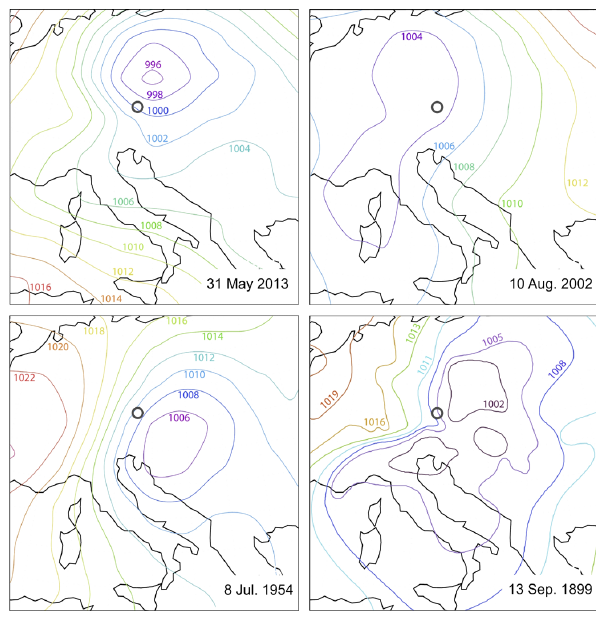
Fig. 3. Sea level pressure (hPa) in central Europe on 31 May 2013 (00:00), 10 August 2002 (12:00), 8 July 1954 (00:00), 13 September 1899 (06:00) (all times in UTC). 2013, 2002 and 1954 are based on the NCEP-NCAR Reanalysis, while 1899 is from Lauda (1900). Circles indicate location of Passau. Times have been chosen as to be most relevant for the precipitation production.